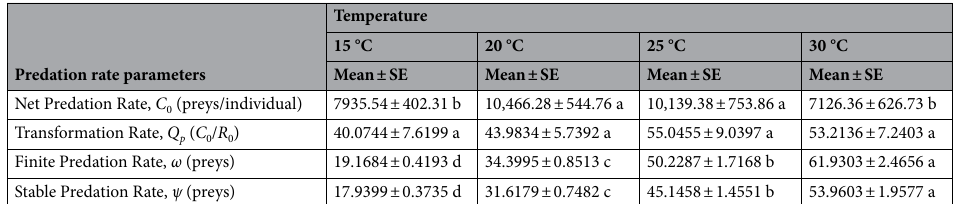
Table 4. Predation rates (Mean ± SE) of Harmonia axyridis fed on Spodoptera litura eggs at four different temperatures. Standard errors were estimated by using the bootstrap technique with 100,000 resampling. Difference was compared using the paired bootstrap test ( P < 0.05). The means within a row followed by a different lowercase letters indicate significant differences among the temperatures.